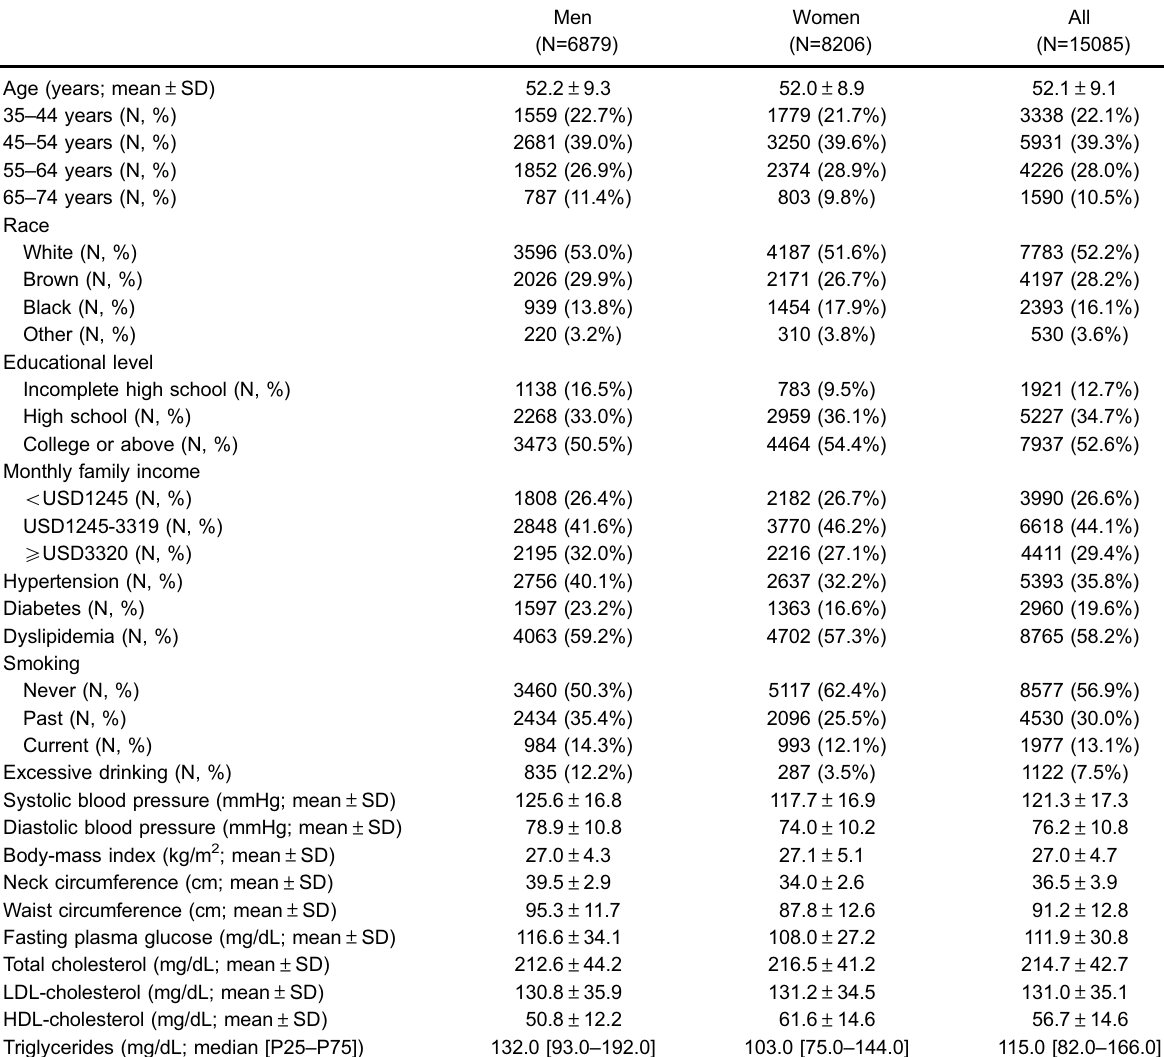
Table 1. Characteristics of the study